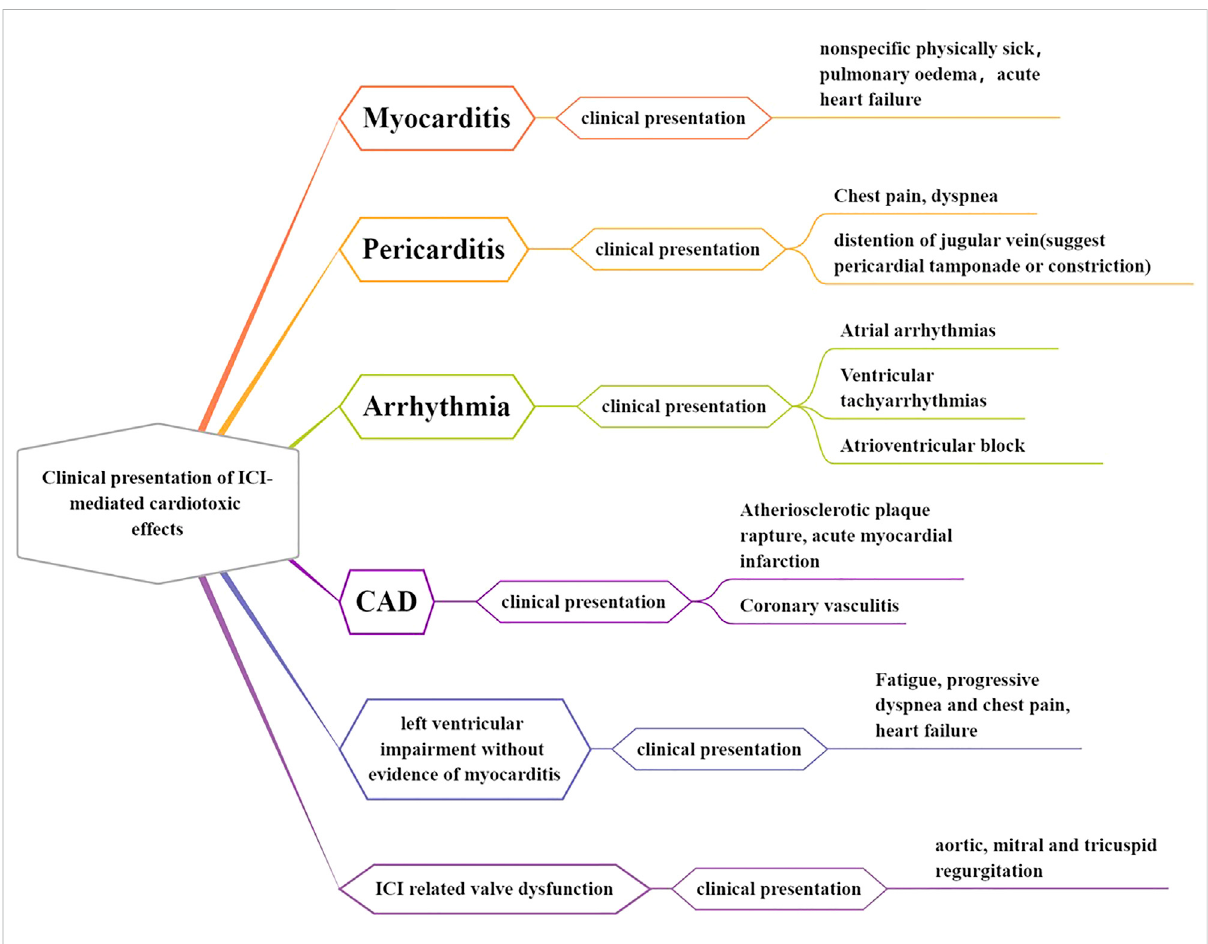
Clinical presentation of ICI-mediated cardiotoxic effects. The ICI-associated clinical trial and reports of current practice suggest that the manifestations of ICI-related cardiotoxicity are diverse, including myocarditis, pericardial disease, arrhythmia, myocardial infarction, and left ventricular (LV) dysfunction without evidence of myocarditis, such as Tako-Tsubo cardiomyopathy